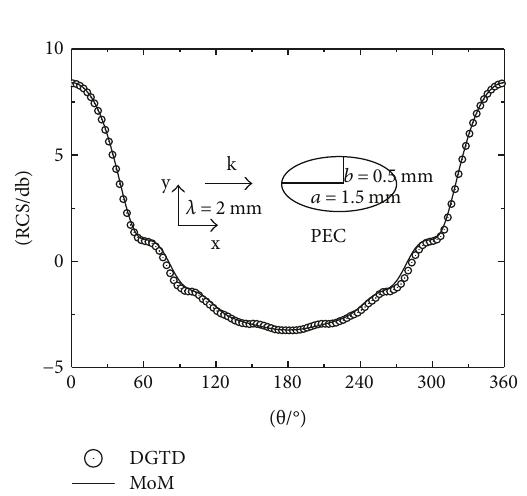
Figure 3: Radiant fi eld and re fl ection error.